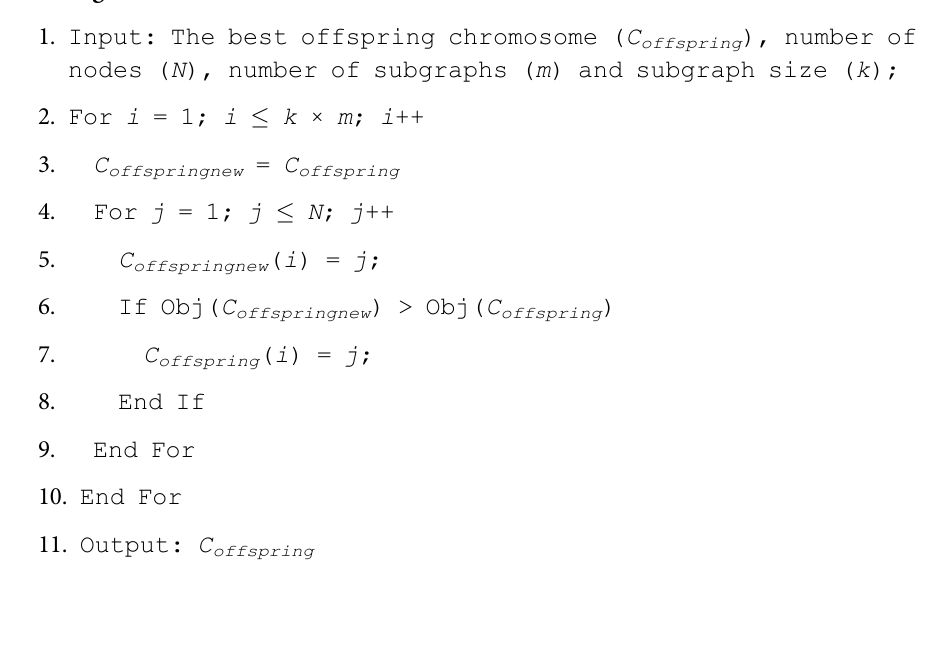
Algorithm 2. Local Search in MA-M m C k SP.